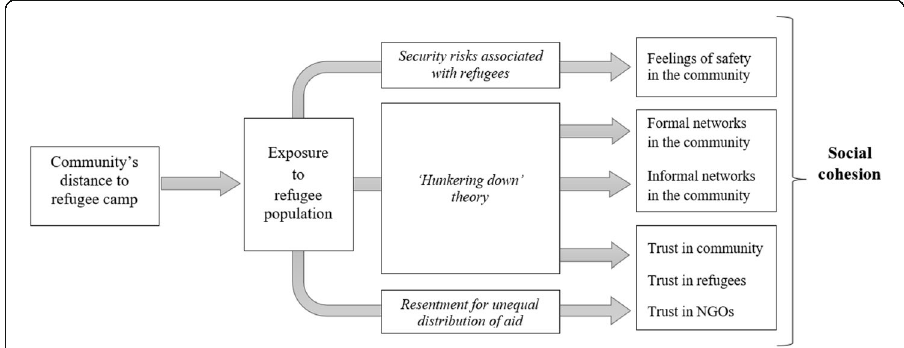
Fig. 1 Conceptual framework: links between proximity to refugee camps and social cohesion in local communities. Legend: